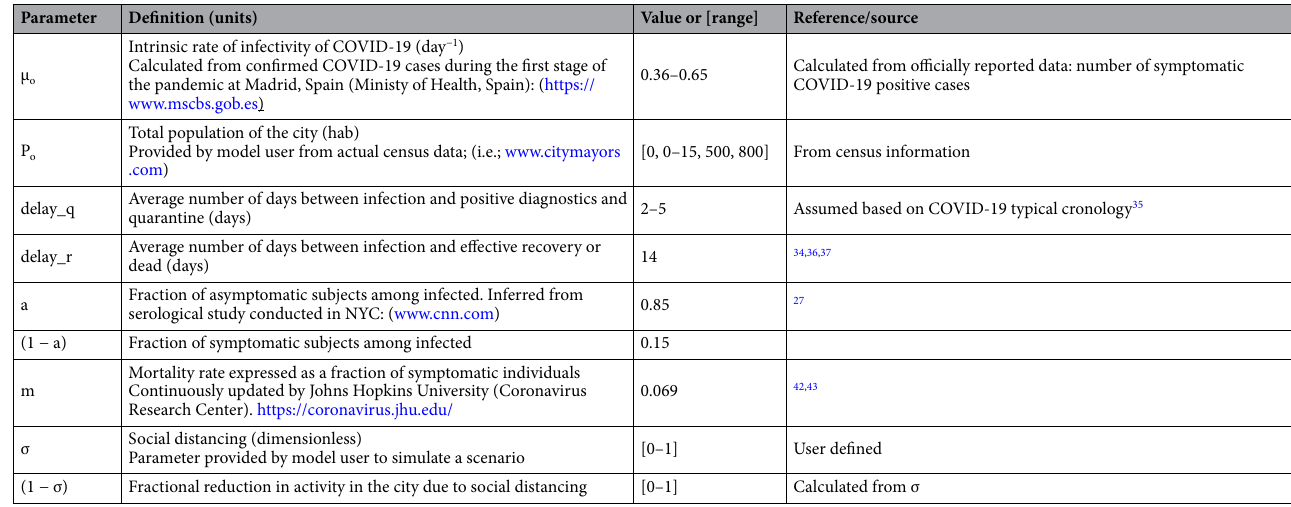
Table 1. Epidemiological data and parameter values used in the